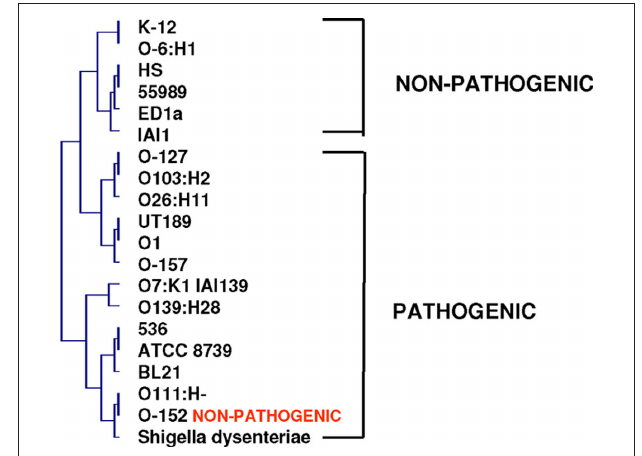
Figure 10 | Phylogenomic tree of E. coli strains and S. dysenteriae based on their gene repertoires. Pathogenic and non-pathogenic species form two separate